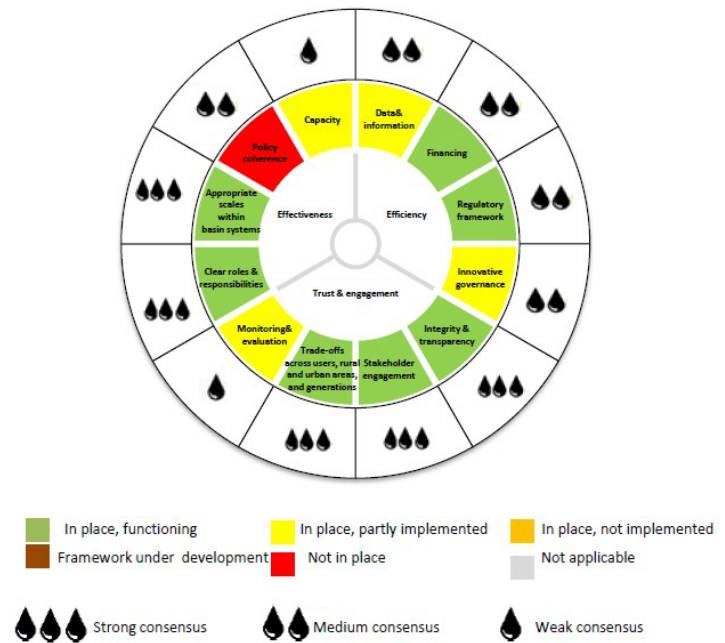
Figure 4. Visual representation of the Traffic Light System. Source: OECD (2018), Implementing the OECD Principles on Water Governance: indicator Framework and evolving practices, OECD Publishing.